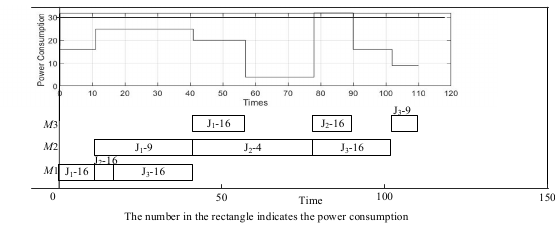
Fig. 1. Gantt Chart for a solution to an example without peak power consumption